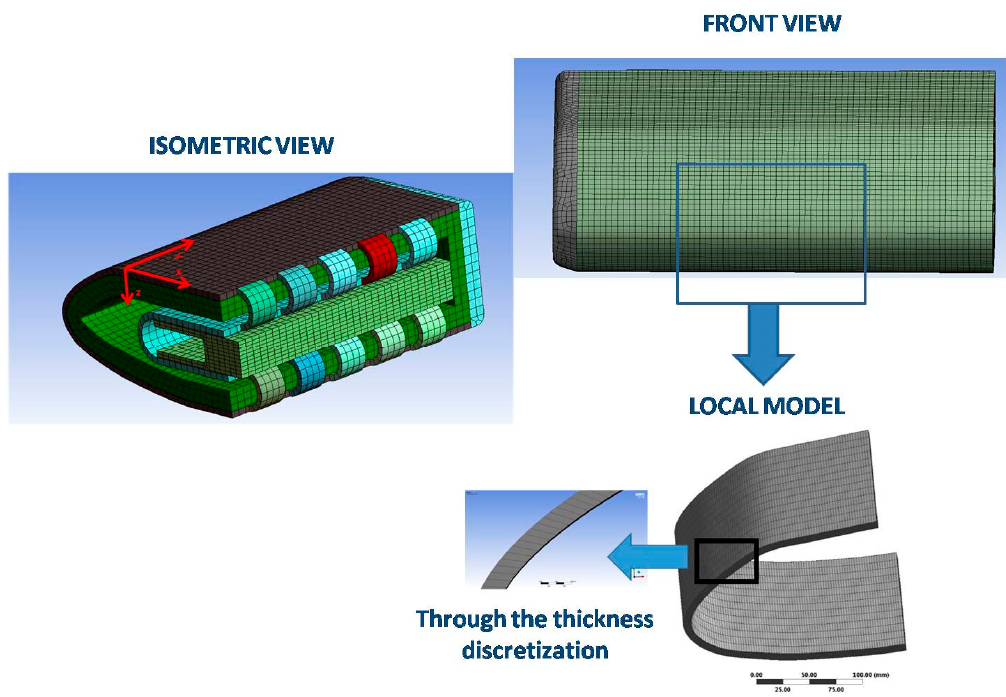
Figure 6. Global coarse shell model—mesh.